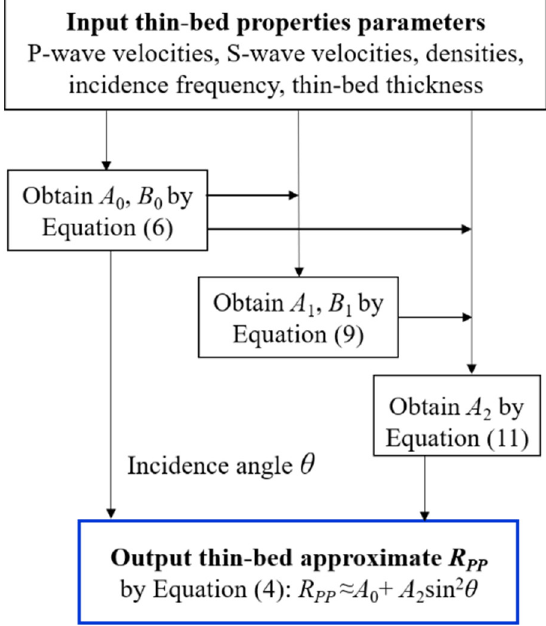
Figure 3. Algorithmic steps of the second-order series approximation.